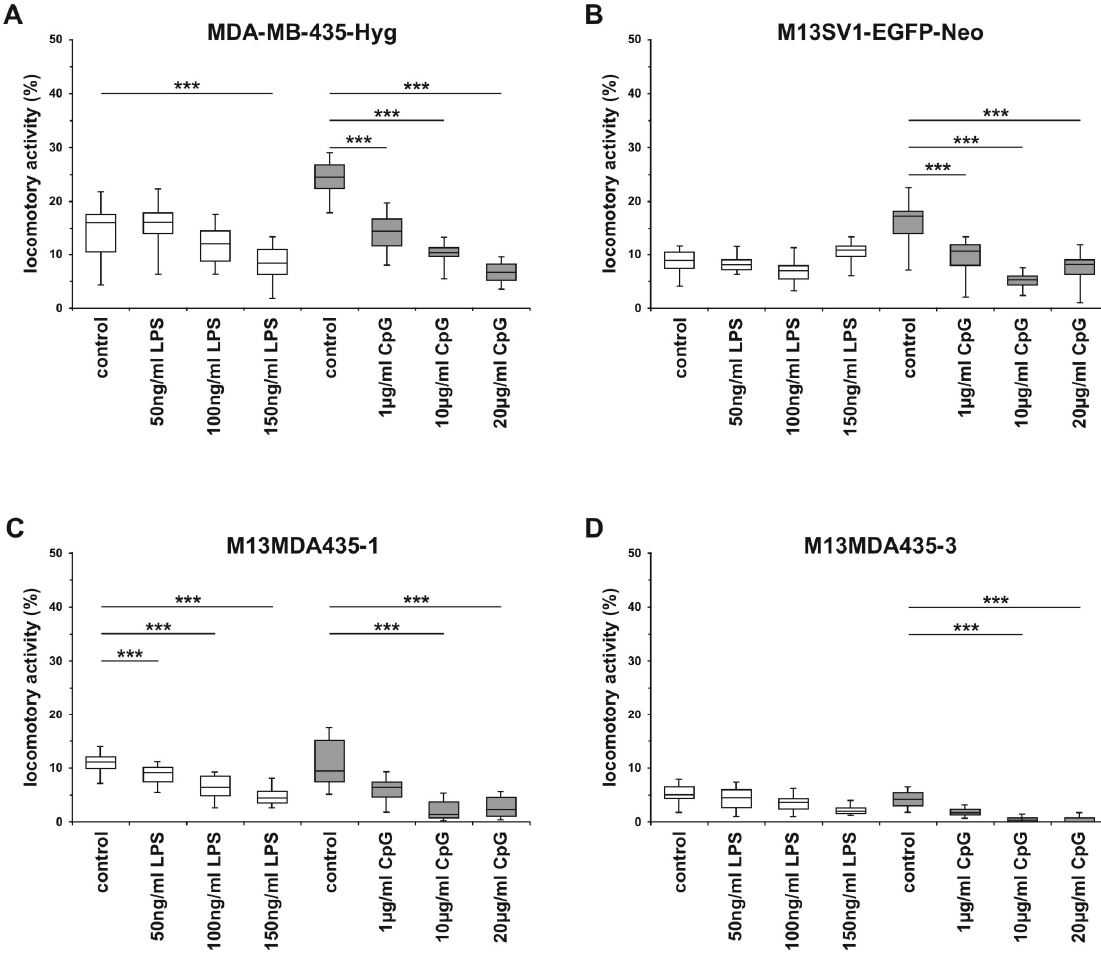
Figure 6. Cell migration data. ( A ) MDA-MB-435-Hyg human breast cancer cells; ( B ) M13SV1-EGFP-Neo human breast epithelial cells; ( C ) M13MDA435-1 hybrid cells; ( D ) M13MDA435-3 hybrid cells. Cells were stimulated with either LPS or CpG-ODN (CpG). CpG inhibited the migratory activity of all cells in a dose dependent manner. The mean locomotory activity ± S.E.M. of the cells is displayed as BoxPlots. Statistical Significance was calculated using the Mann-Whitney- U -test (*** <0.01). Shown are the means of at least three independent experiments.